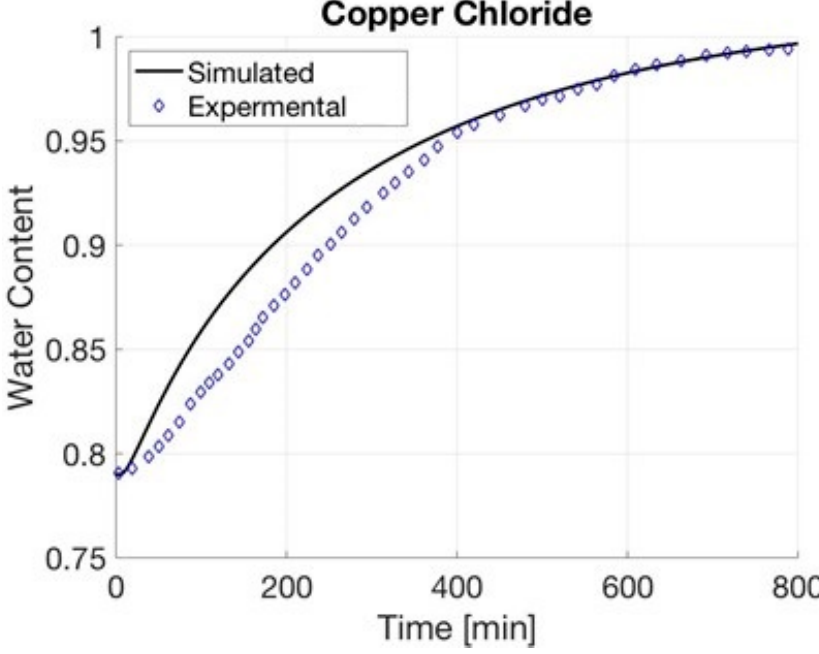
Figure 10. Comparison of HAW model of copper chloride